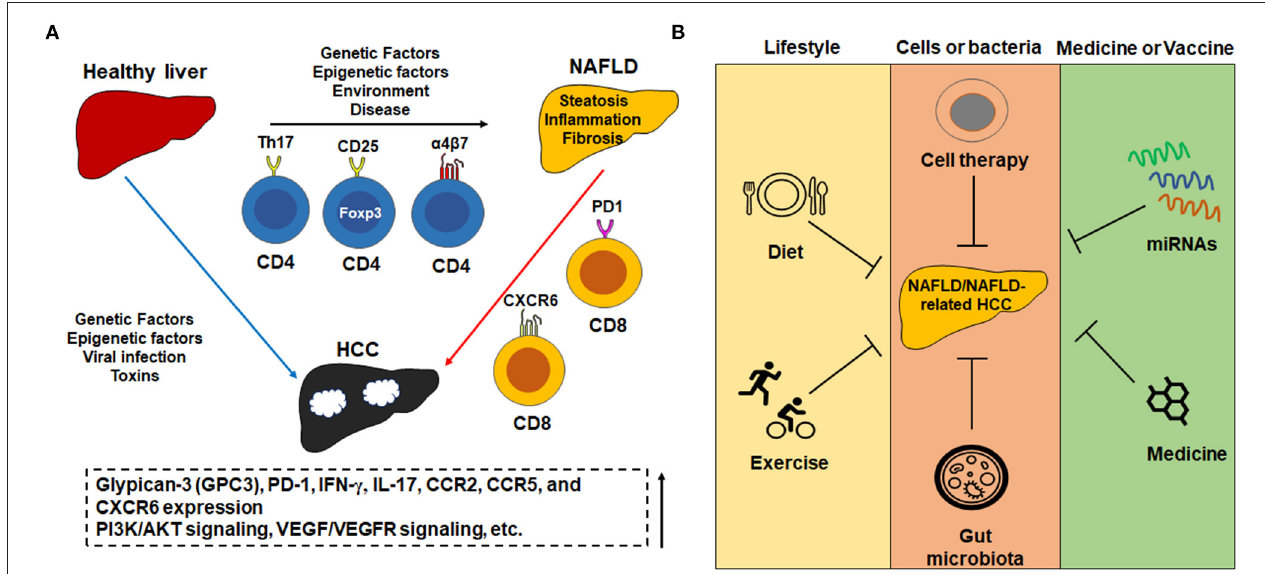
FIGURE 1 | The important role of T cells in the pathogenesis of NAFLD and NAFLD-related HCC and potential treatment options. (A) Some important subtypes of T cells and molecules in the pathogenesis of NAFLD and NAFLD-related HCC. For example, Th17 + CD4 + , CD25 + Foxp3 + CD4 + , and α 4 β 7 integrin-positive CD4 + T cells increase in the progression of NAFLD, while PD1 + CD8 + and CXCR6 + CD8 + increase in NAFLD-HCC progression. The change of T cell population is associated with an increase of cytokines such as IL-17a and IFN- γ which accompany the progression of NAFLD. (B) The potential treatment options for NAFLD and NAFLD-related HCC include change of lifestyle, cells or bacteria-mediated therapy such as adoptive transfer of T cells, medicines or vaccines such as microRNA-mediated therapy.